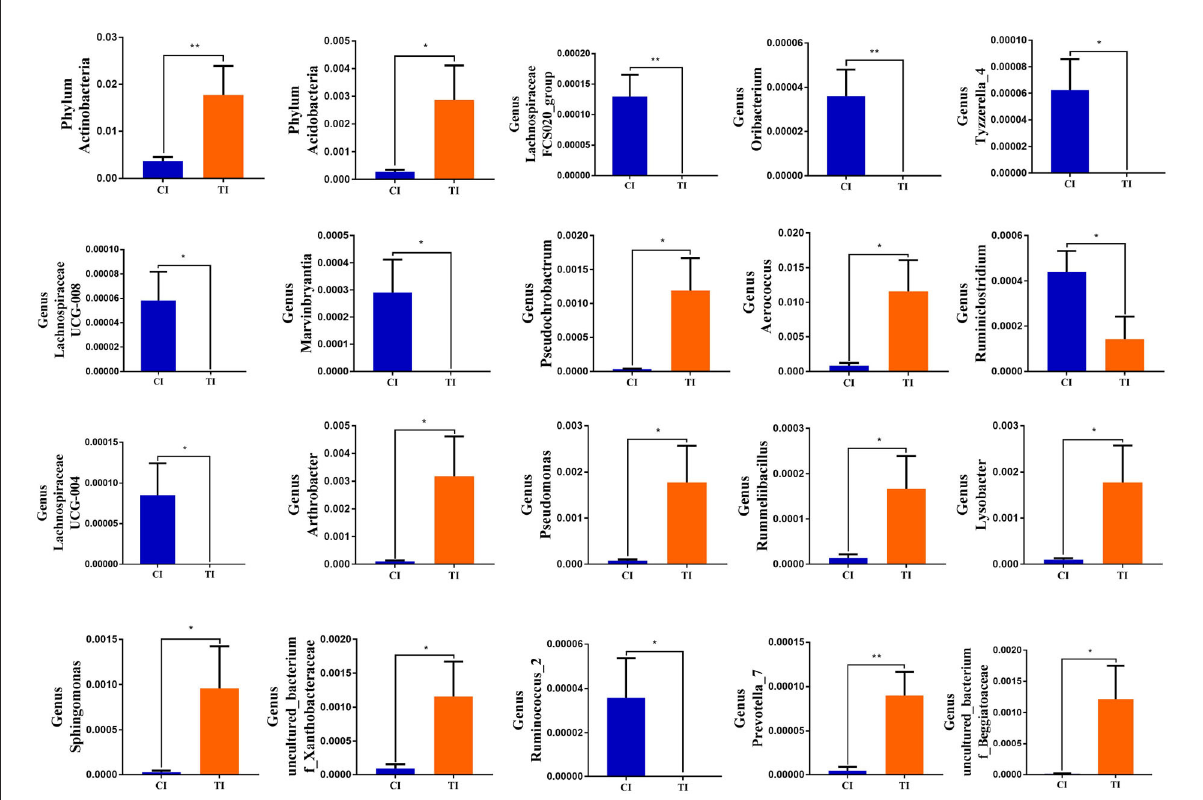
FIGURE4 Significant shifts in the gut microbial compositions during thiram exposure. Metastats analysis displayed microbial changes between both groups. All data were represented as mean ± SD. * p < 0.05, ** p <